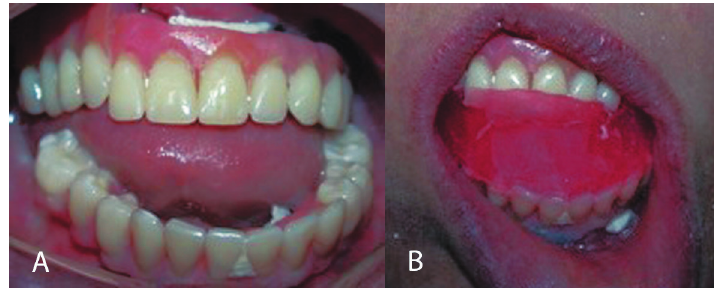
Figure 4- The prosthesis was cut to level the maxilla (A) and new position was registered